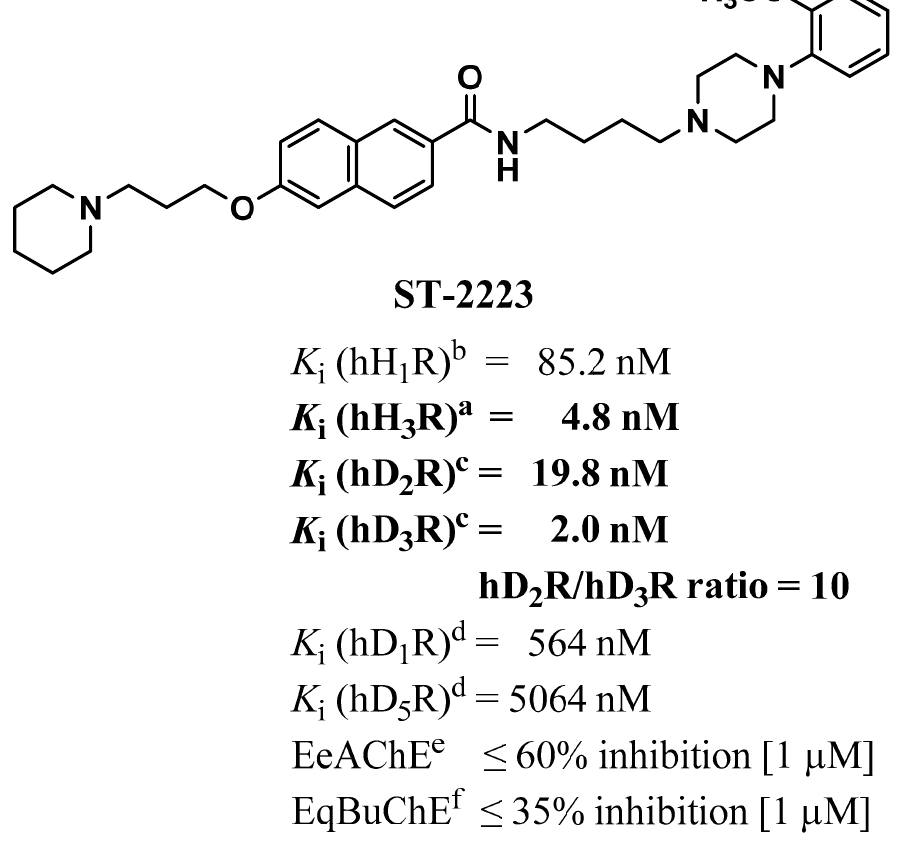
Figure 1. Chemical structure of the multi-targeting ligand ST-2223 with affinities at h H 3 R, h D 2 R and h D 3 R. a [ 3 H] N α -methylhistamine binding assay, performed with cell membrane preparation of Human embryonic kidney (HEK) cells stably expressing the human H 3 R ( n = 4) [44,45]. b [ 3 H]pyrilamine binding assay, performed with cell membrane preparation of Chinese hamster ovary (CHO) cells stably expressing the h H 1 R ( n = 2). c,d Displacement assay was carried out as described previously, using membrane suspension of cell lines stably expressing the human dopamine h D 1 Rs and h D 5 Rs (HEK) against [ 3 H]SCH23390 and h D 2 SRs, h D 3 Rs (CHO) using [ 3 H]spiperone ( n = 3) [44,45]. e AChE: Acetylcholine esterase; Ee; electric eel (preliminary data); f BuChE: Butyrylcholinesterase;Eq: equine (preliminary data) ( n = 2) [46].